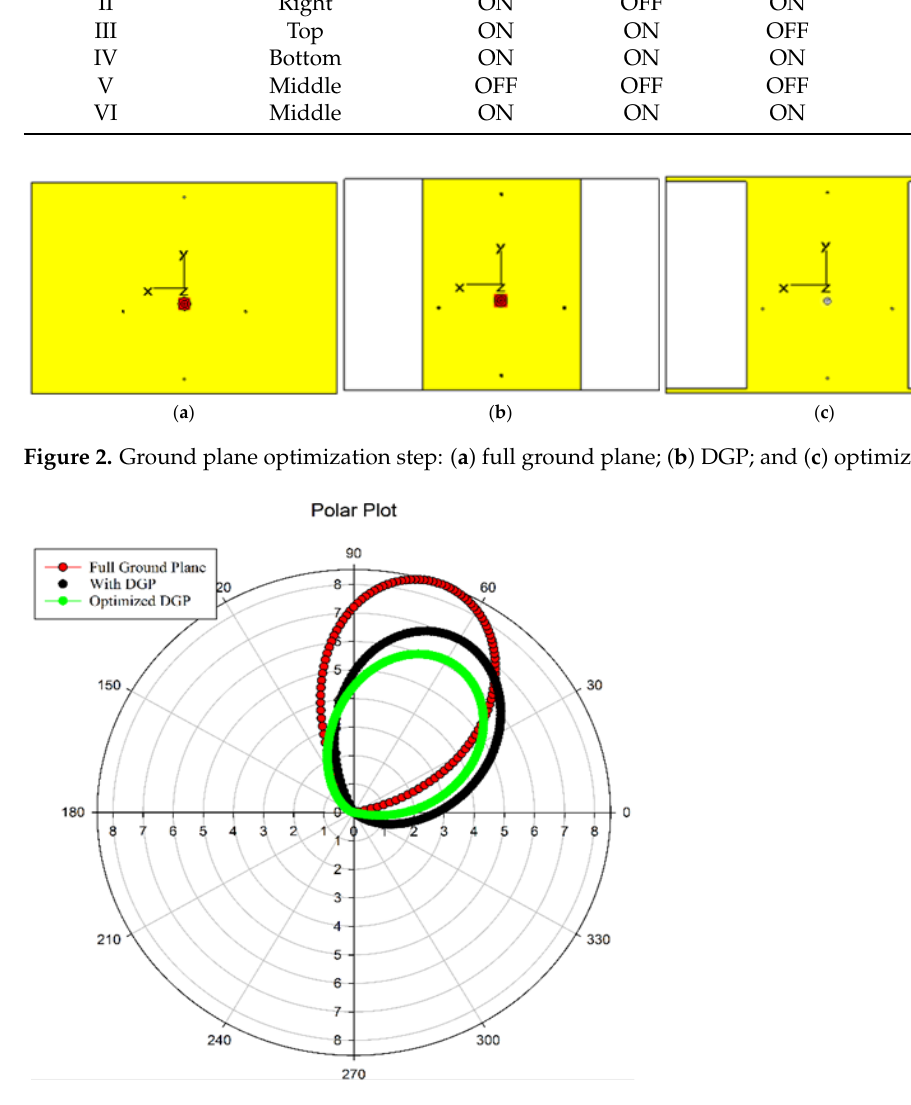
Figure 3. The polar plot radiation pattern for a different type of ground plane. Table 2. Angle tilting comparison for different types of ground planes (simulated) .